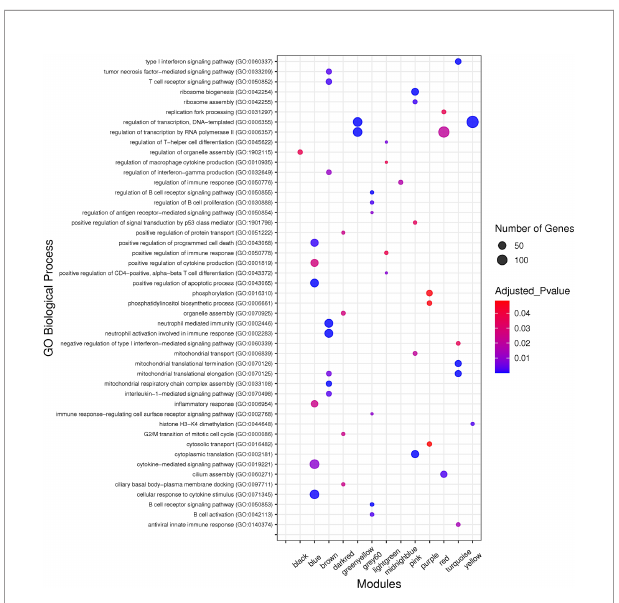
FIGURE 4 | The top GO biological processes of the non-preserved modules. The y axis and the x axis represent signi fi cant enriched GO terms and module name, respectively. Color and size of each point represent adjusted p value and number of genes for each term,